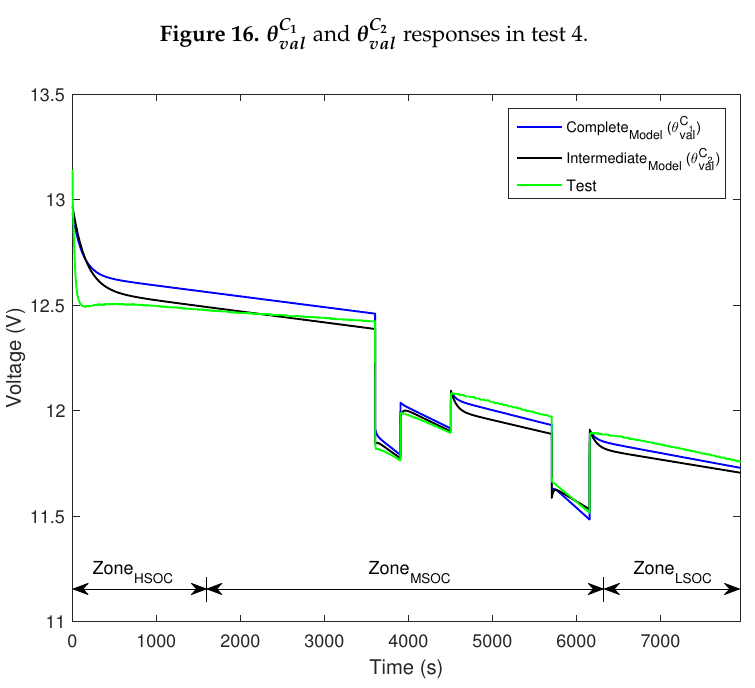
Figure 17. θ C 1